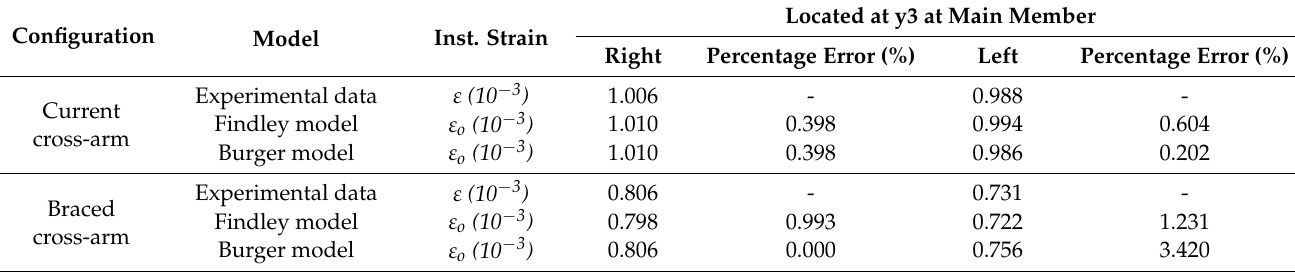
Table 5. Comparison of instantaneous strain value between experimental outputs and numerical models located at y3 for current and braced wooden